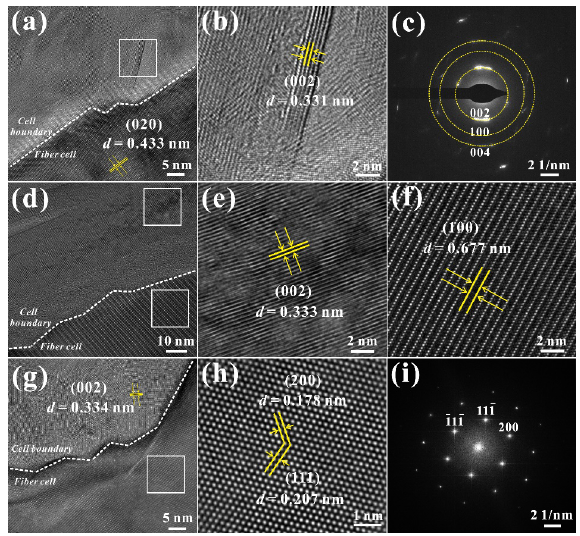
Fig. 4 HRTEM analysis of the as-sintered PcBN/hBN fibrous monolithic ceramics. (a, d, g) show the low-magnification TEM images at the interface between the fiber cell and the cell boundary. (b, c) represent the magnified HRTEM and SAED images of the cell boundary marked in rectangle in (a), respectively; (e, f) denote the magnified HRTEM images marked in rectangle in (d), respectively; and (h, i) exhibit the atomic-resolution HRTEM and FFT images marked in rectangle in (g),